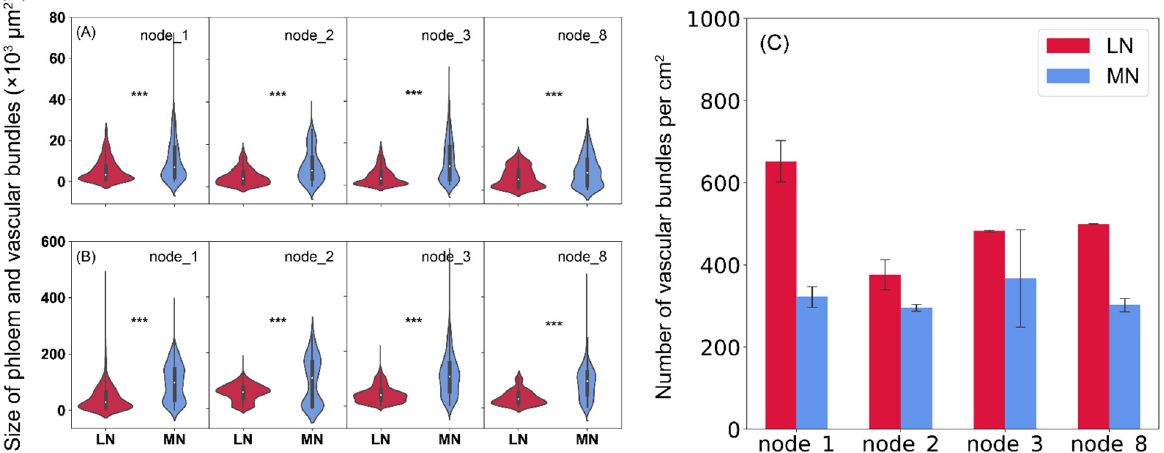
Figure 6. The size of phloem ( A ) and vascular bundles ( B ), and number of vascular bundles per unit area (cm 2 ) ( C ) in the stem base node (node_1), two nodes above stem base (node_2 and node_3), and the node_8 of maize plants at 62 days after sowing under low and medium N supply. The solid line and dash line within each box represent the median and mean values of all data in panels ( A ) and ( B ). The top and bottom edges represent the 75 and 25 percentiles, and the top and bottom bars represent the 95 and 5 percentiles of all data, respectively. ***, p < 0.001.